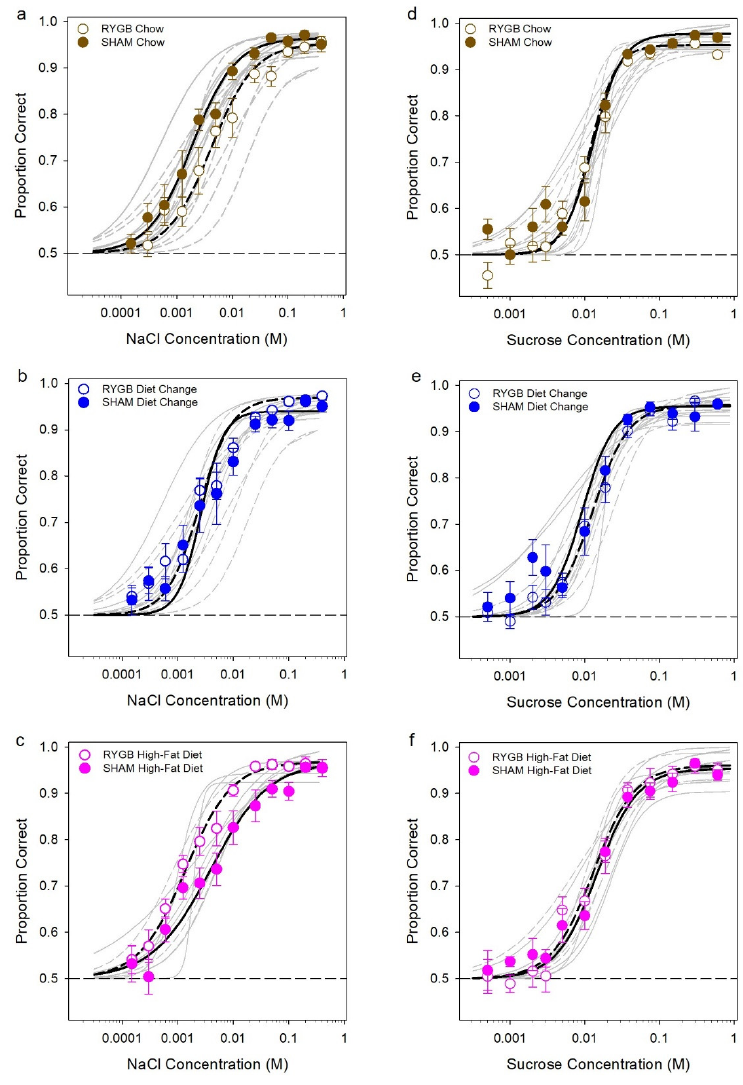
Figure 6. The effect of surgery for each diet condition. Mean (±SE, standard error) proportion correct as a function of stimulus concentration for NaCl ( a – c ) and sucrose ( d – f ); Chow groups in the top row, DC in the middle row, and HFD in the bottom row. Solid line on curve fits reflects group averages; the grey lines are for individual data based on the 3-parameter logistic function described in Data Analysis. RYGB animals are represented by open circles and dashed lines and SHAMs by filled circles and solid lines. The horizontal dashed line represents chance performance in this task.